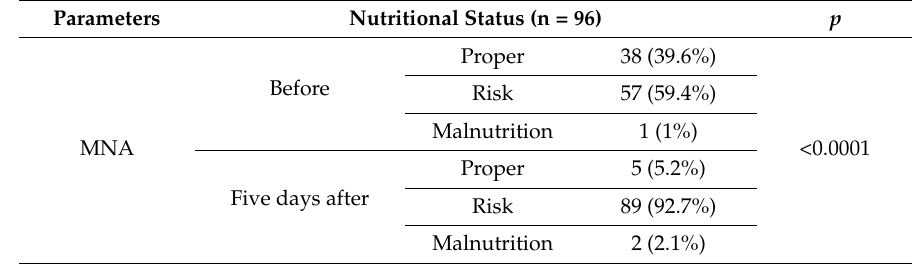
Table 6. Nutritional status of patients based on MNA. Parameters